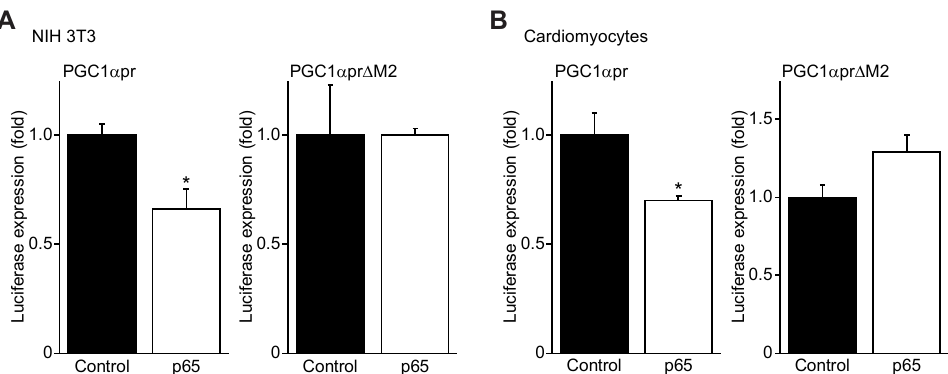
Figure 4. PGC-1α promoter activity is repressed by NF-κB. ( A , B ) Luciferase reporter assay of the mouse PGC-1α promoter in ( A ) NIH 3T3 cells or ( B ) rat post-natal cardiac myocytes transduced with empty vector alone (Control) or NF-κB p65 expression cassette, with normalization to co-transfected Renilla luciferase. * p < 0.05 versus Control.